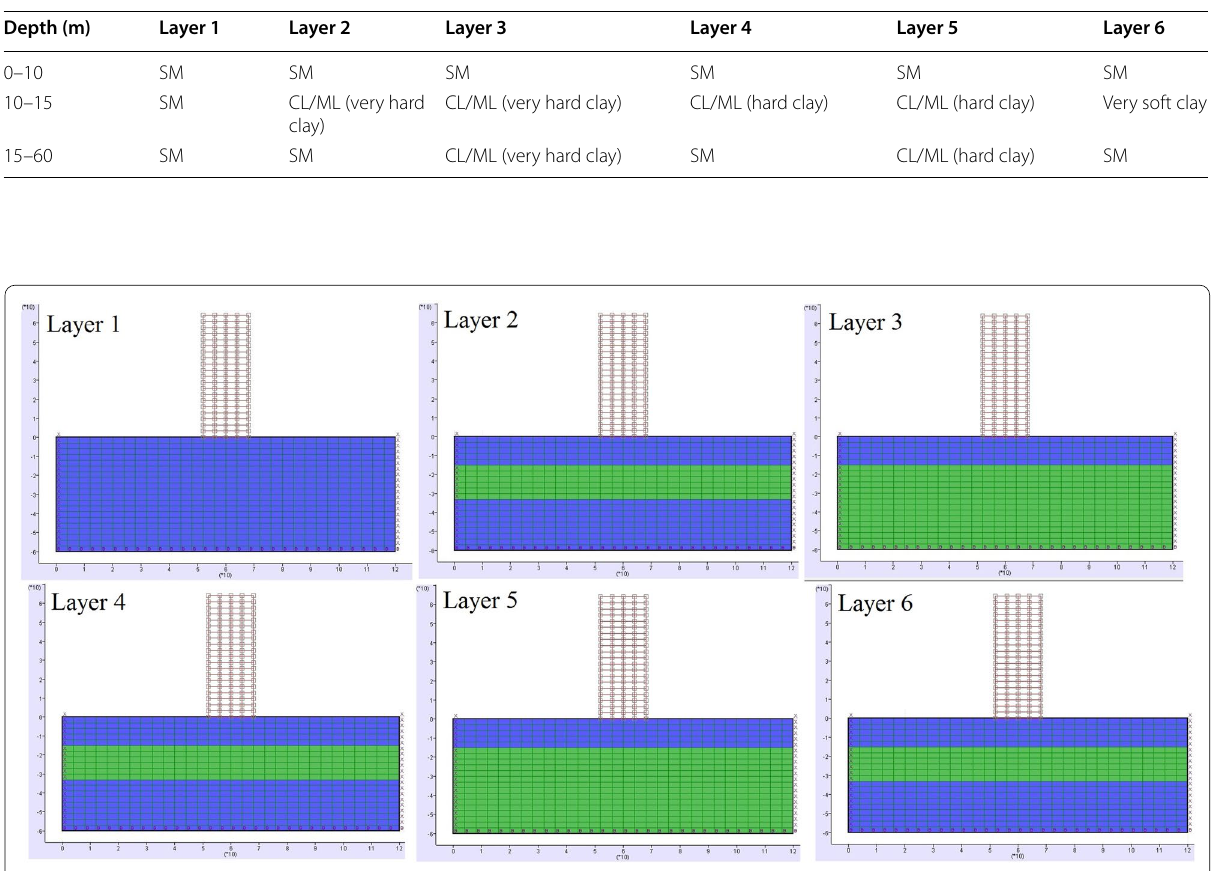
Fig. 15 Modeling of the 20-story RC frames with different soil layers in FLAC